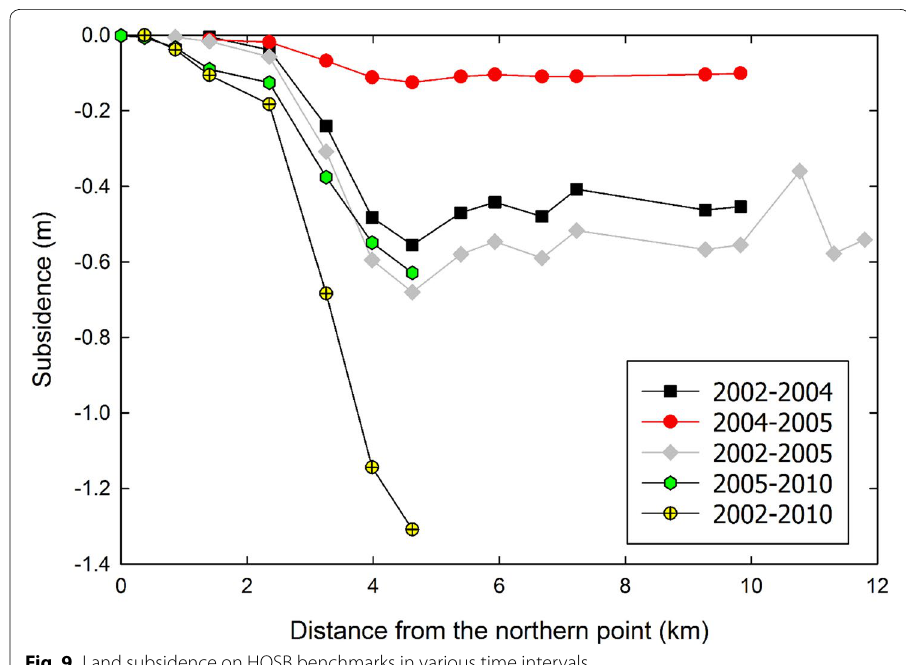
Fig. 9 Land subsidence on HQSB benchmarks in various time intervals